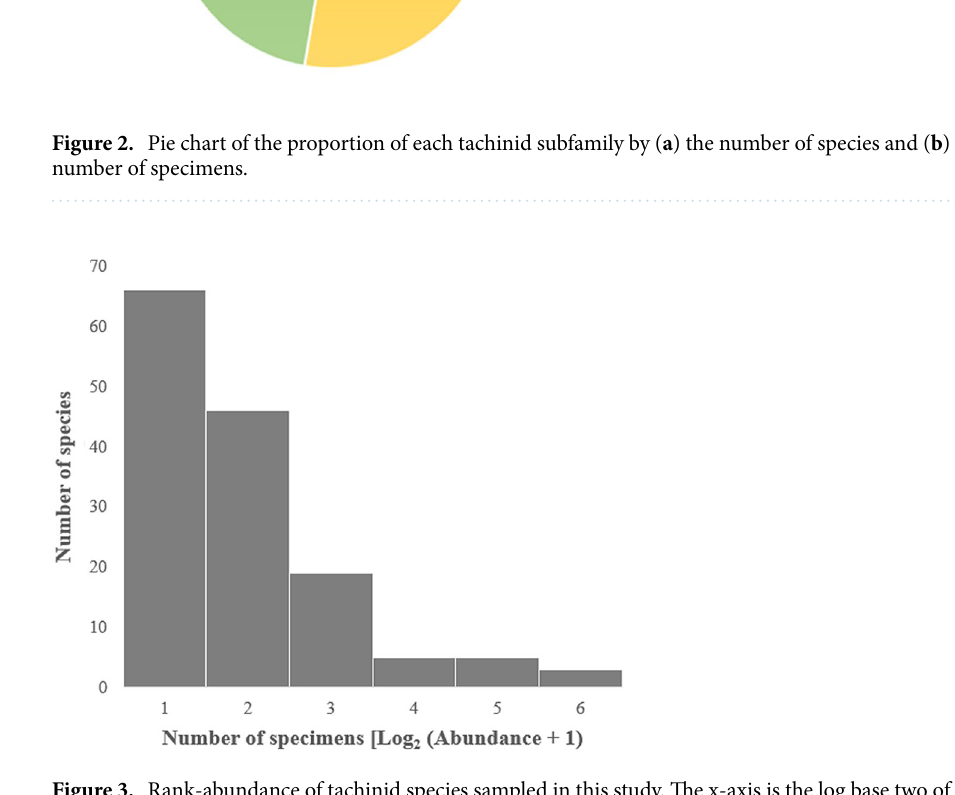
Figure 3. Rank-abundance of tachinid species sampled in this study. The x-axis is the log base two of the specimens abundance plus